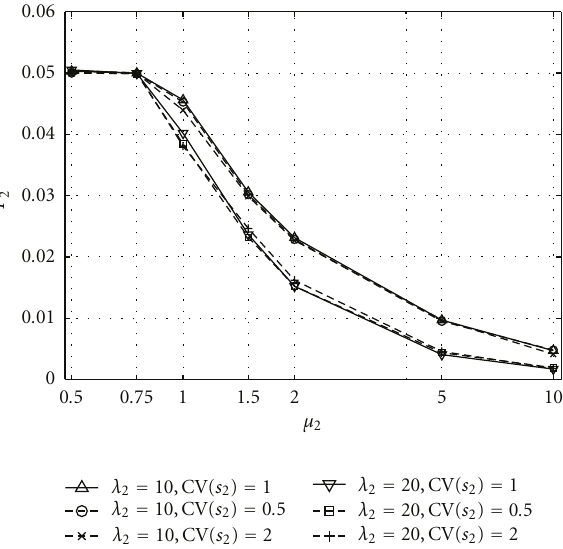
Figure 9: Sensitivity of P ft 2 to E [ s 2 ] and CV[ s 2 ] in system 3a.